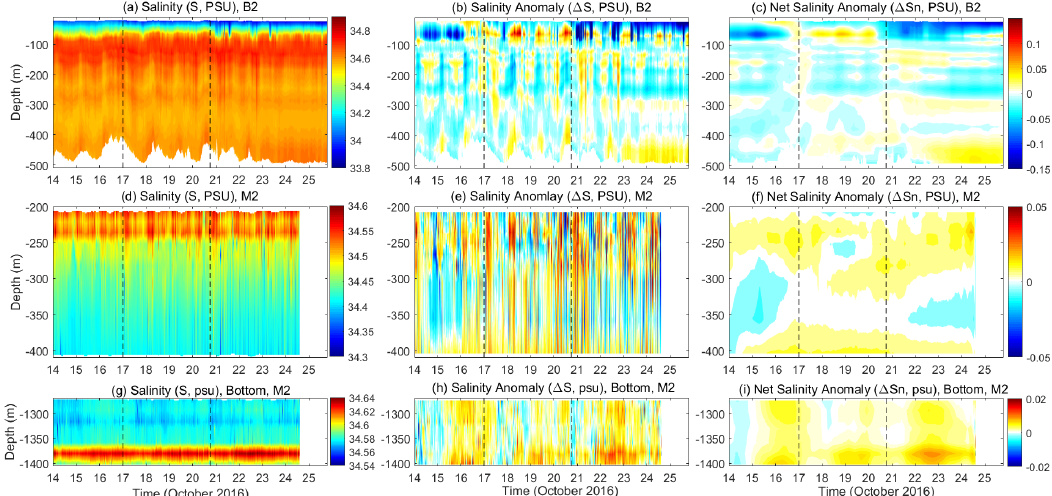
Figure 11. Salinity, salinity anomaly, and net salinity anomaly during Sarika and Haima at Buoy 2 ( a – c ) and Mooring 2 ( d – i ). Net salinity anomaly is the one inertial period running mean of the salinity anomaly. The salinity anomaly was calculated as the salinity minus the average salinity over the period UTC 00:00 on 14 October to UTC 00:00 on 16 October. Dashed lines represent the time that Sarika and Haima were closest to the